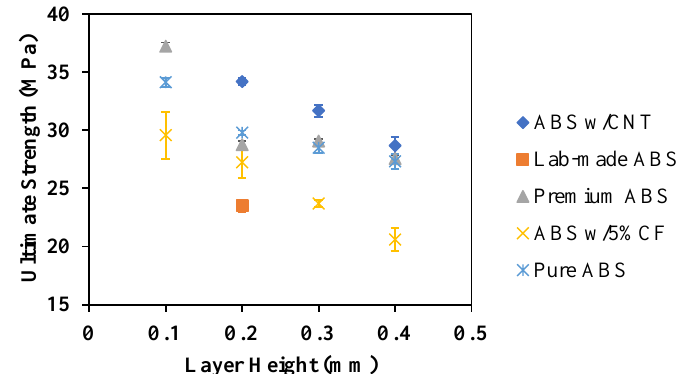
Figure 14. Young’s Modulus of ABS materials as a function of layer height.